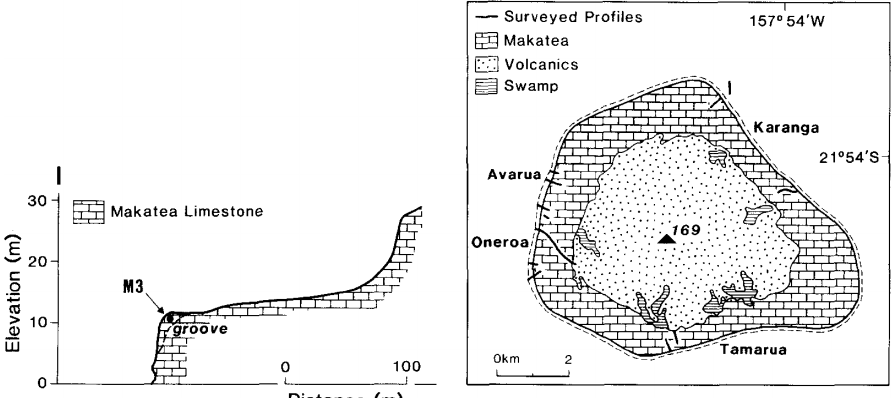
Figure 16. Sea-level indicators on Mangaia, Cook Islands. Selected profiles and dated samples are shown (from Woodroffe et al., 1991).